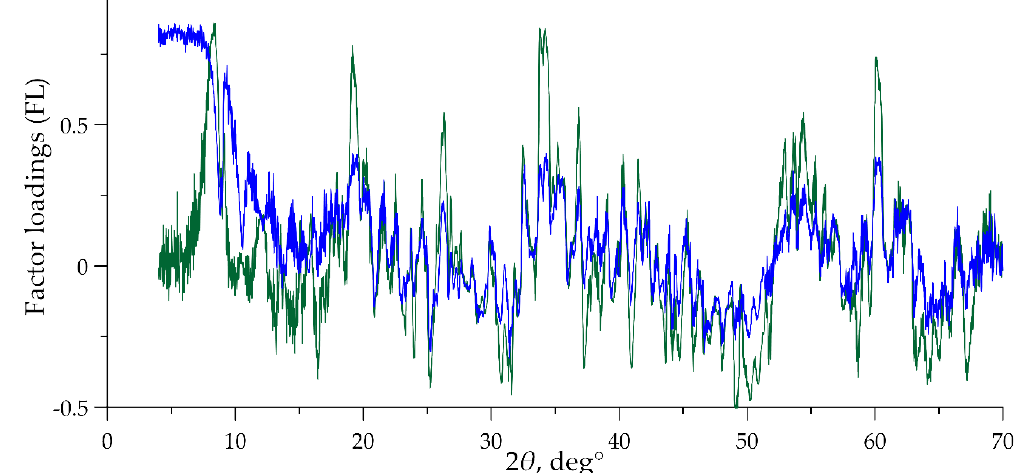
Figure 7. Comparison of the FL graphs of a specific factor, containing information about the baseline in the raw dataset (green line), and its closest analog from the result of applying FA to the “raw data vs. baseline correction” dataset (blue line).